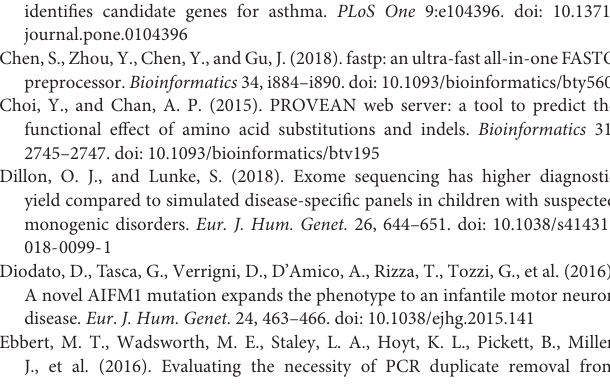
TABLE S1 | Demographics and clinical feature HPO input and output of the cohort. TABLE S2 | Frequency of the systems affected in the cohort. TABLE S3 | The detailed data quality of WES and CNVseq for the cohort. TABLE S4 | Detailed information of the variants identified in the cohort by Trio-WES. TABLE S5 | Comparison of general clinical information and sequencing data in patients with a positive and negative molecular